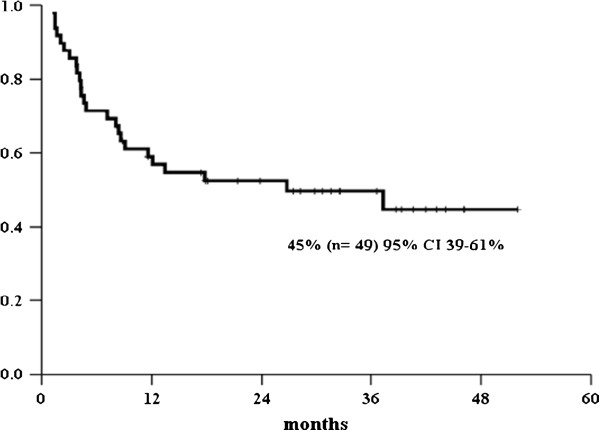
Overall survival.